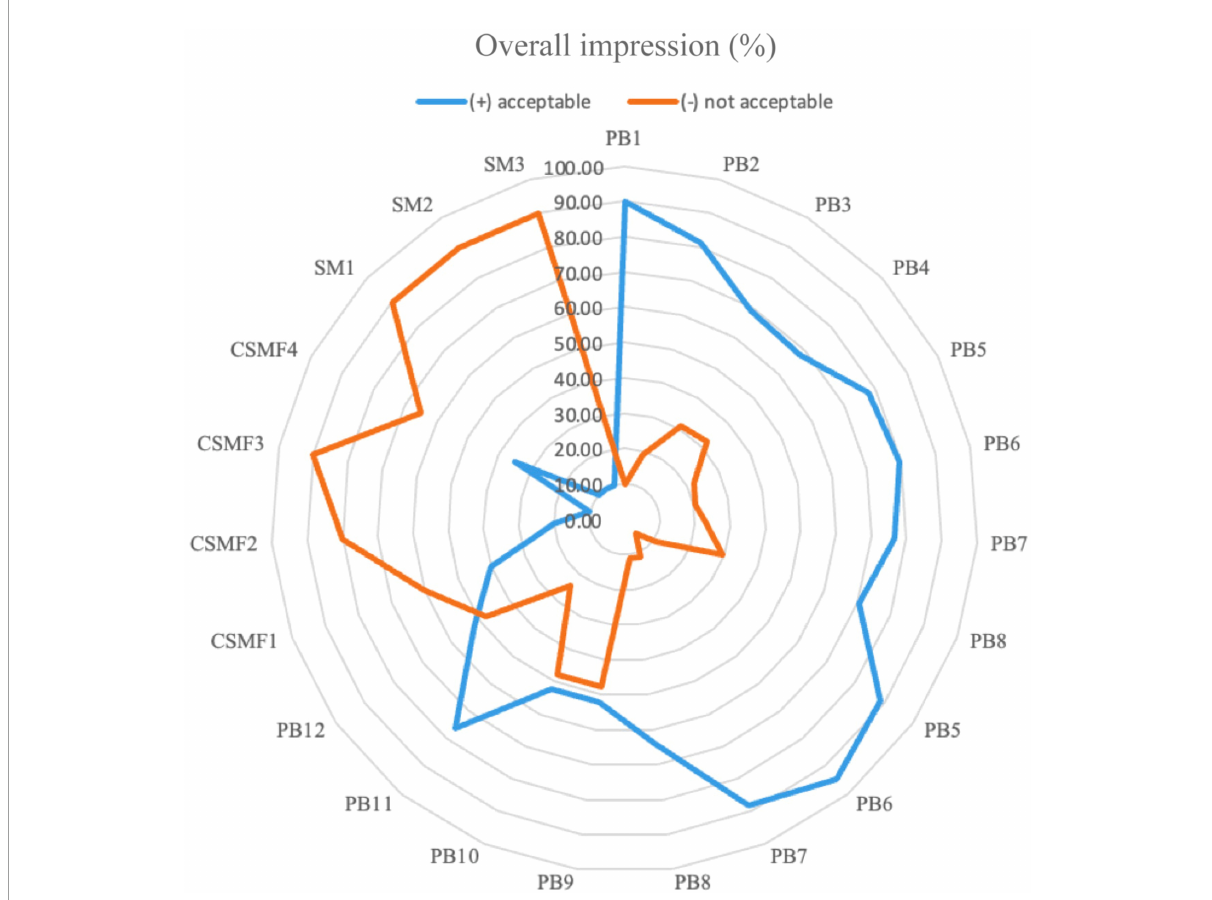
FIGURE8 Radar plot of the overall acceptance of the PBs compared with CSMFs and SMs at day 21. Legend: PB1–PB4: (CSMF1–CSMF4) + UTNGt2; PB5–PB8: (CSMF1–CSMF4) + UTNGt5; PB9–PB12: (CSMF1–CSMF4) + L.Lac; PB13–PB16: (CSMF1–CSMF4) + L.r. CSMF1: semi-skimmed milk + 1% cocoa + 2% glucose; CSMF2: semi-skimmed milk + 2% cocoa + 2% glucose; CSMF3: semi-skimmed milk + 3% cocoa + 2% glucose; CSMF4: semi-skimmed milk + 2% glucose; SM1: semi-skimmed milk + 1% sterile distilled water + 2% glucose; SM2: semi-skimmed milk +